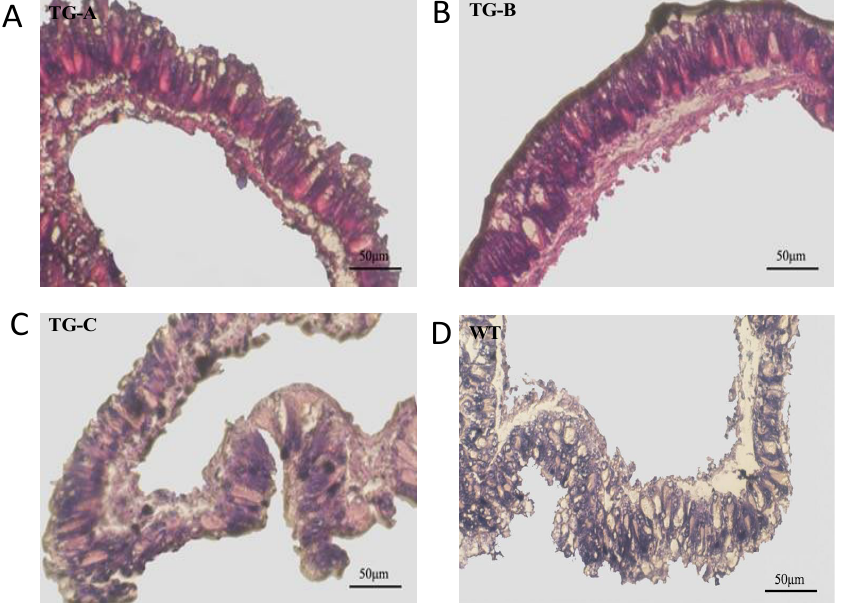
Figure 5. Microscopy of midguts of the transgenic and WT silkworms after BmNPV infection. The midguts of TG-A ( A ), TG-B ( B ), TG-C ( C ), and WT ( D ) silkworms infected with 10 6 OBs/larva